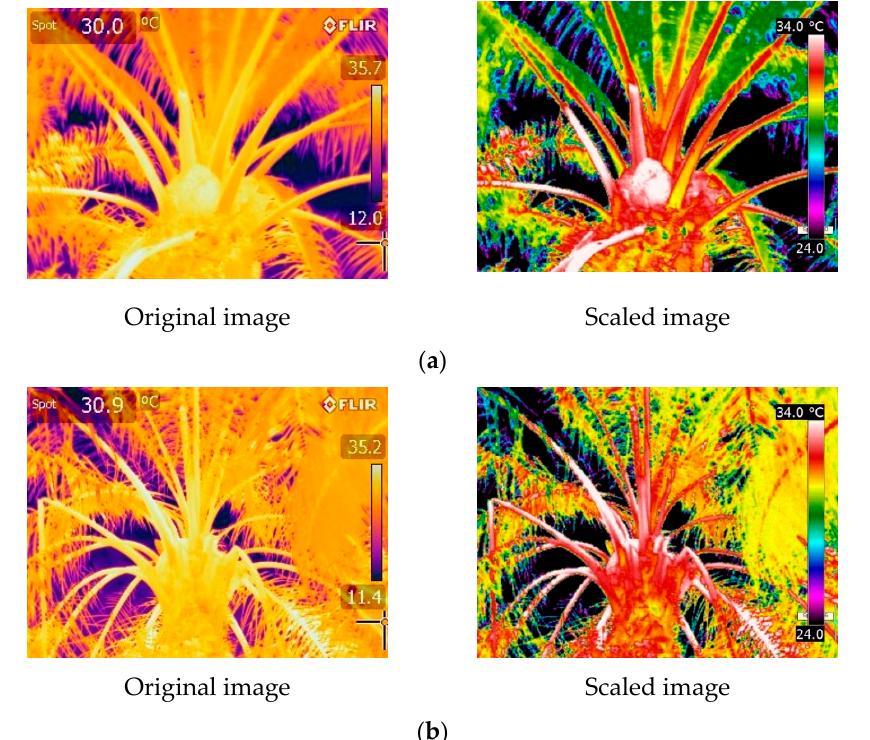
Figure 4. Thermal images of ( a ) healthy palm ( b ) basal stem rot (BSR)-infected palm. When the images used the same scaled, the temperature of the leaves taken from BSR-infected palm was higher than the healthy palm.